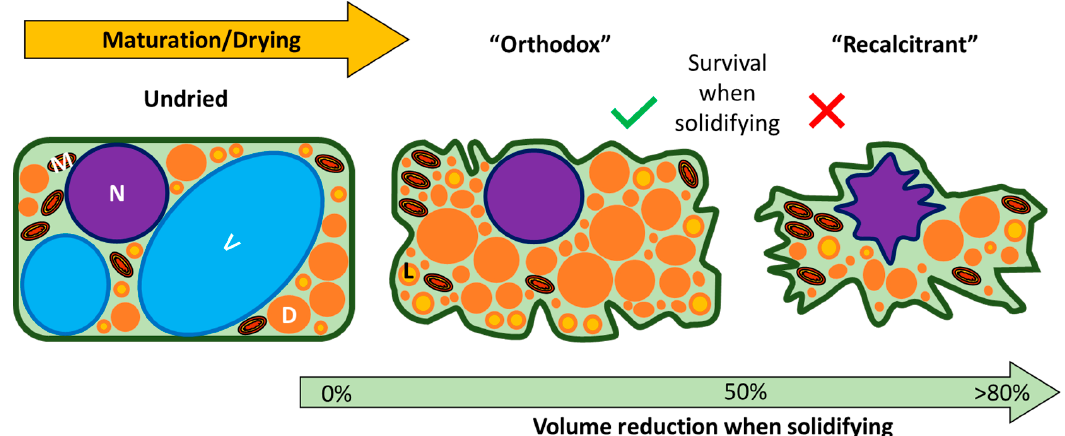
Figure 2. Schematic diagram to illustrate hypothetical differences in cell shrinkage during the drying of orthodox and recalcitrant seed tissues. In orthodox seed cells, dry mass accumulates during maturation and fills the cell volume. Hence, a desiccation force causes only slight cell shrinkage. In contrast, the accumulation of space-filling reserves in recalcitrant seeds is less marked, causing considerable cell shrinkage when a drying force is applied. V, vacuole; N, nucleus; L, lipid body; M, mitochondria; D, other storage reserves, such as plastids filled with starch or protein bodies, or complexes formed by LEA and HSP and raffinose or other oligosaccharides (see, e.g., [22,35]).